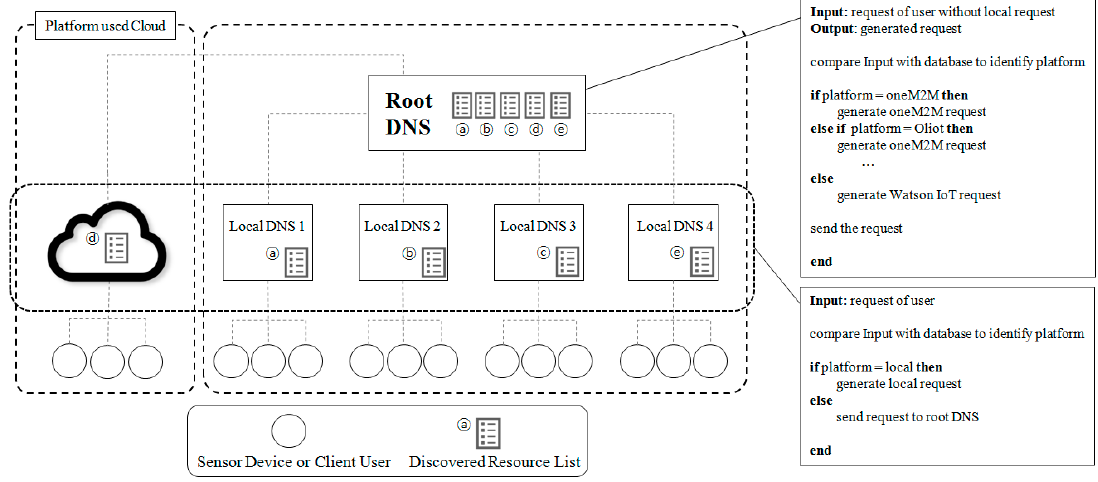
Figure 8. IoT DNS architecture. Figure 8. IoT DNS